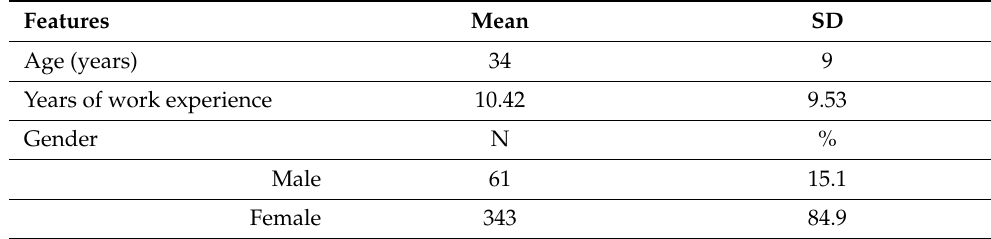
Table 1. Characteristics of the study group (N =